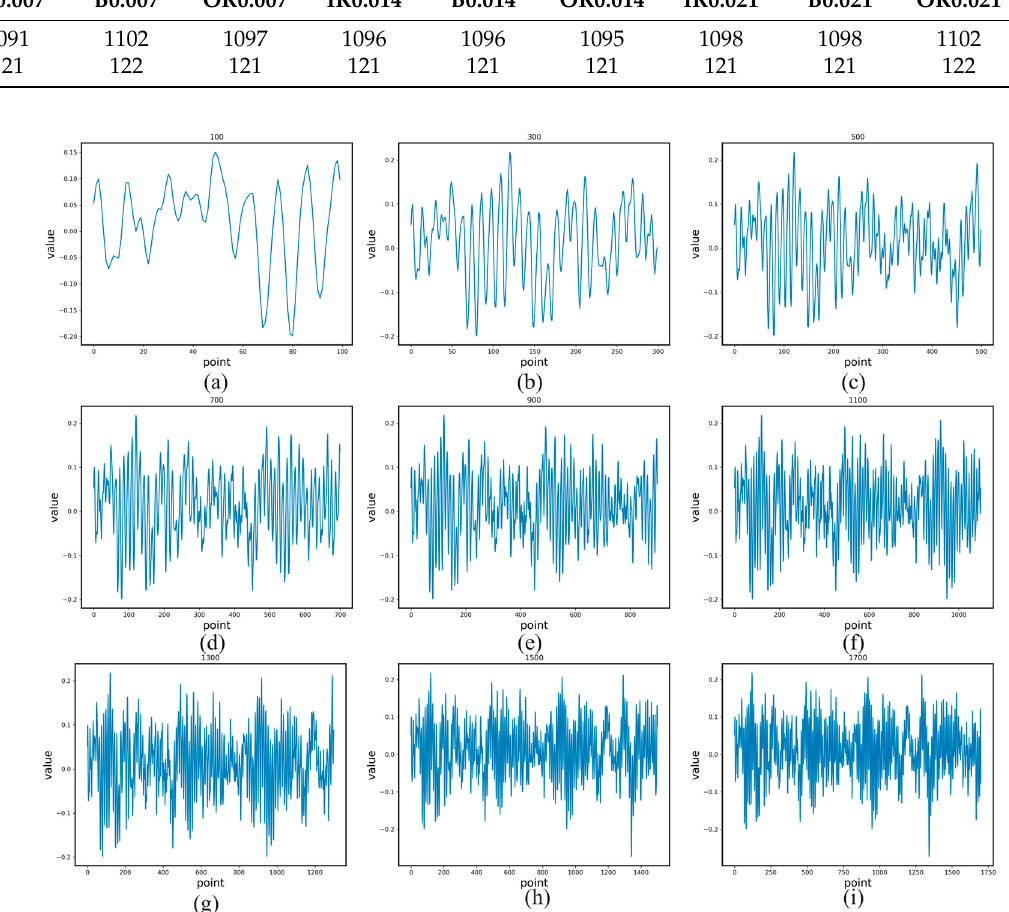
Figure 2. The segmentation results of the same signal in the CWRU dataset are segmented according to the number of data points: ( a ) 100 points, ( b ) 300 points, ( c ) 500 points, ( d ) 700 points, ( e ) 900 points, ( f ) 1100 points, ( g ) 1300 points, ( h ) 1500 points and ( i ) 1700 points.